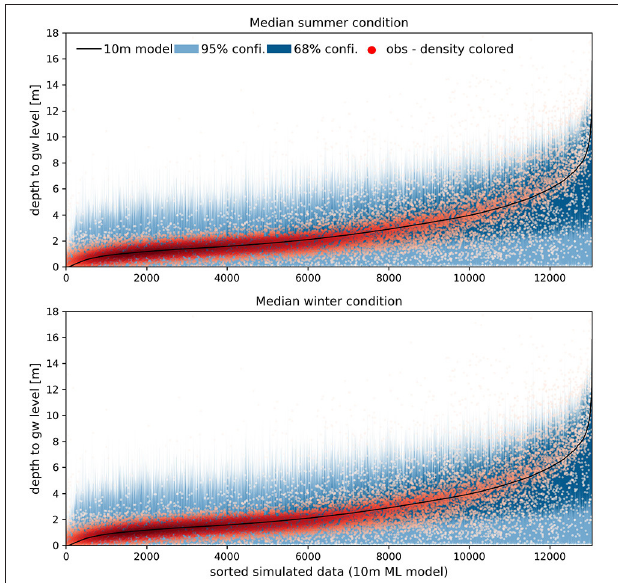
FIGURE 7 | Results of the 4-fold cross validation test for summer model (top) and winter model (bottom). The simulated data are sorted, and the observations are plotted as point density. Only well observations are shown in the plot. Uncertainty bands are included for two confidence